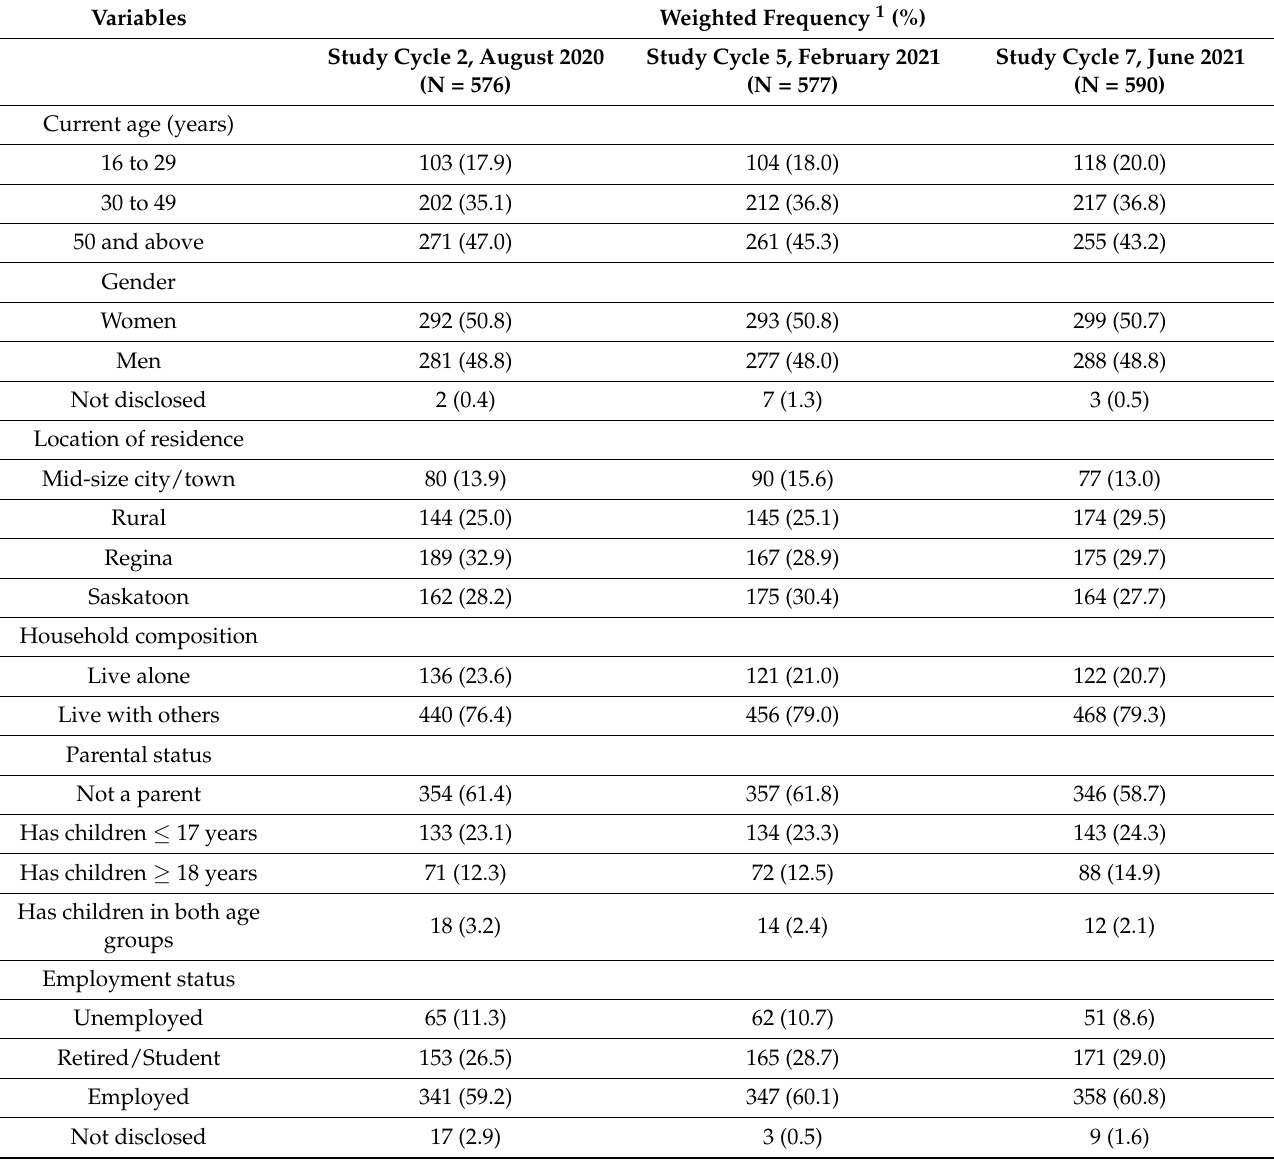
Table 1. Characteristics of the Mental Health Research Canada—Saskatchewan study